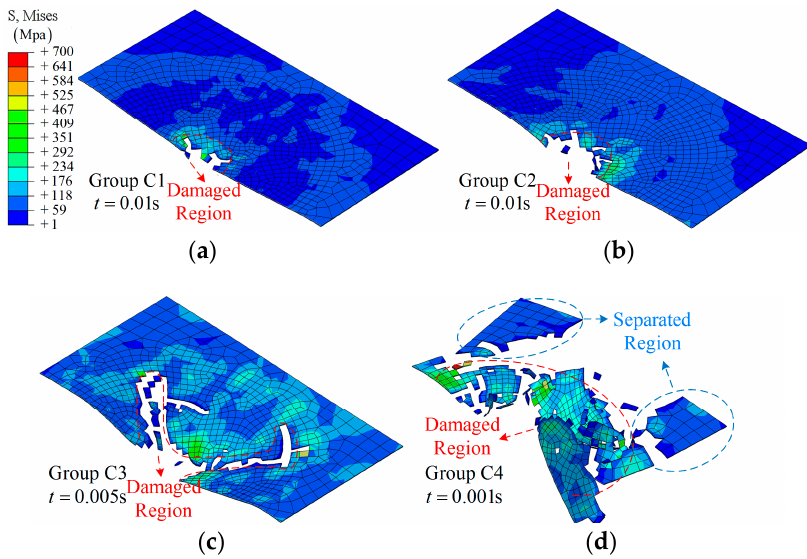
Figure 11. The fracture morphology of the top layer of the SMA-reinforced composite laminate under different amplitudes: ( a ) Group C1; ( b ) Group C2; ( c ) Group C3; ( d ) Group C4.